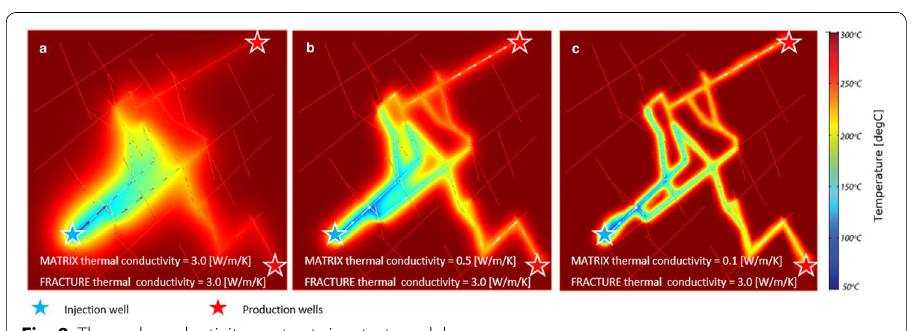
Fig. 8 Thermal conductivity contrasts in a test